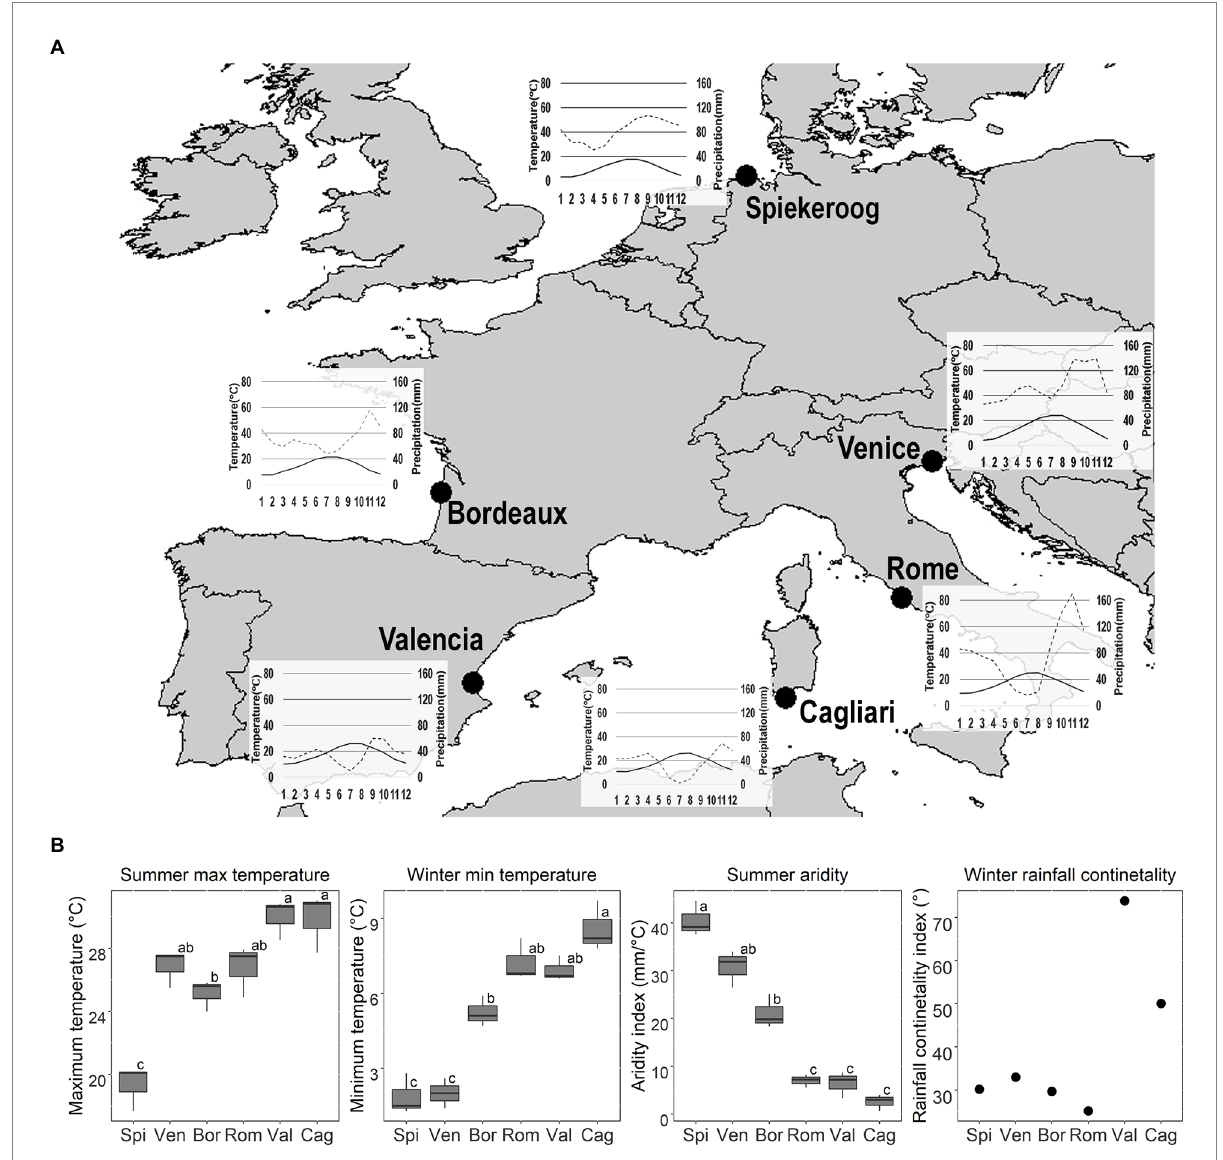
FIGURE 1 Seed collection sites, coordinates (Latitude and Longitude, in decimal degrees) and seed collection date: Spi = Spiekeroog (53.79360; 7.71150; 12/09/2019); Ven = Venice (45.69365; 13.08790; 24/07/2019): Bor = Bordeaux (44.76700; − 1.20000; 21/07/2019); Rom = Rome (41.69210; 12.30090; 09/07/2019); Val = Valencia (39.36827; − 0.30850; 08/08/2019); Cag = Cagliari (38.84522; 8.86276; 05/08/2019). Seeds of both species were collected on the same day, with the exception of C. arenaria from Rome, which was collected on 10/09/2019. Climatic data were sourced from www.Climate-Data.org, and from the available localities nearest to the sites of seed collection (for Spiekeroog: Spiekeroog; for Venice: Ca ′ Ballarin; for Bordeaux: Lège-Cap-Ferret; for Rome: Fiumicino; for Valencia: Valencia; for Cagliari: Domus de Maria). (A) Thermopluviometric diagrams. Black line: temperature (T ° C); Grey dashed line: precipitation (P mm). (B) Average summer (June–August) maximum T and aridity index, winter (December–February) minimum T, and rainfall continentality index for each site. High values of the aridity index indicate greater P regimes and/or lower summer T, thus, lower summer drought. Different letters indicate significant differences to the post-hoc Tukey